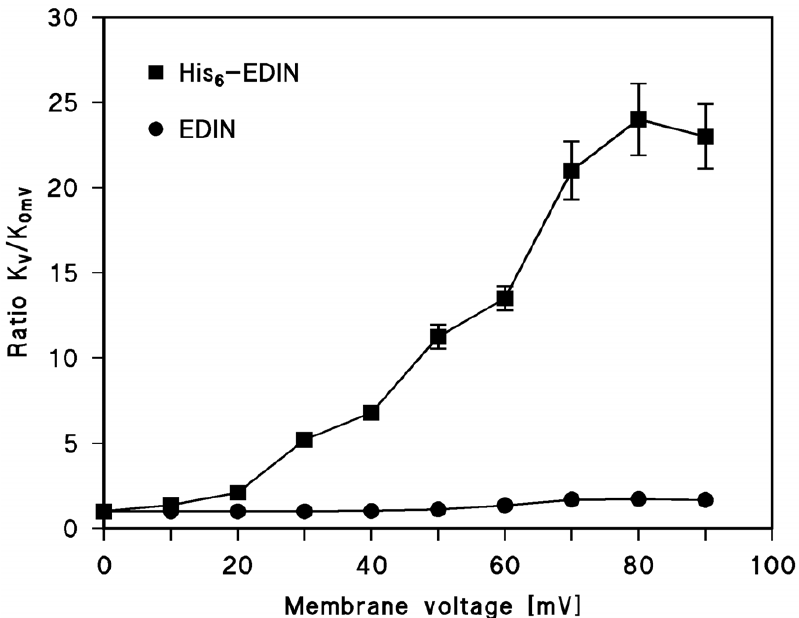
Figure 6. Correlation of affinity constant K and voltage dependence of PA 63 -channels in presence of EDIN and His 6 -EDIN. The stability constants of EDIN and His6-EDIN binding to the PA 63 -channel are given as a function of the applied membrane potential taken from experiments similar to that shown in Fig. 5 A/B. Means of three experiments are shown.